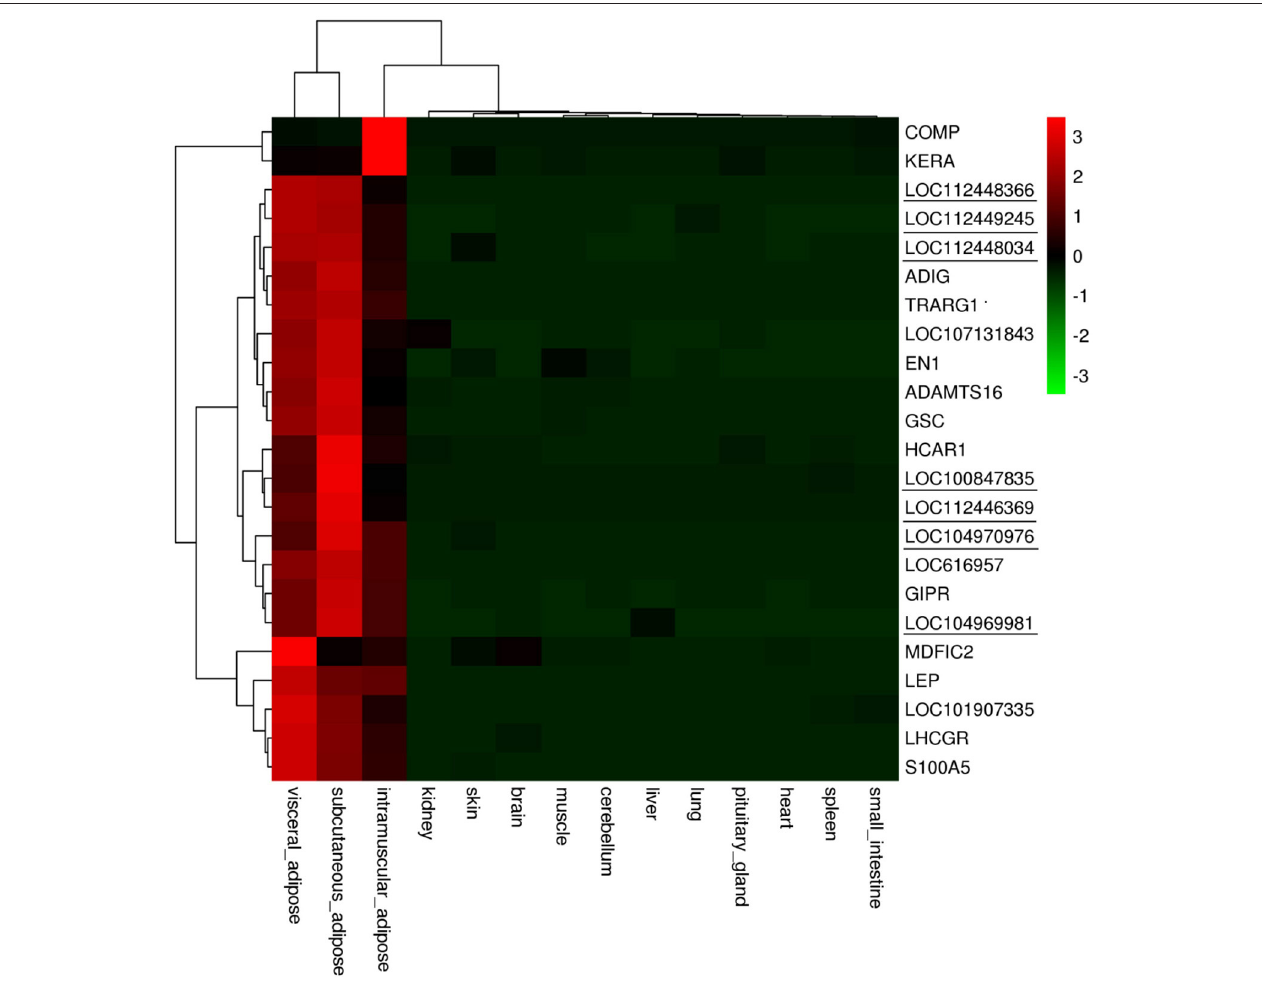
FIGURE 9 | Expression levels of adipose tissue-specific and highly expressed genes in different tissues. Genes marked with underline are lncRNA